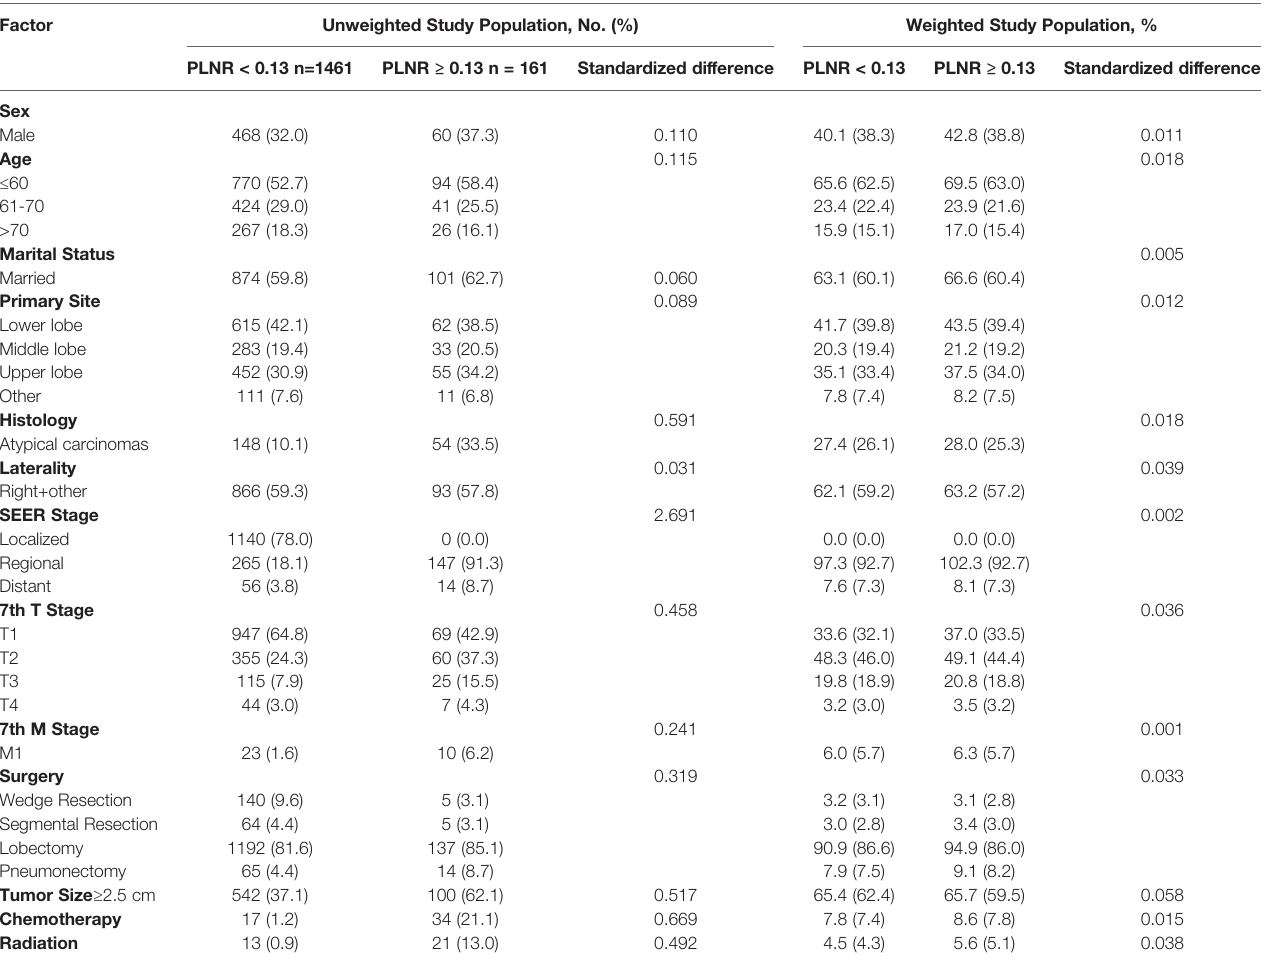
TABLE 1 | Selected baseline characteristics between PLNR<0.13 and PLNR ≥ 0.13 before and after weighting.